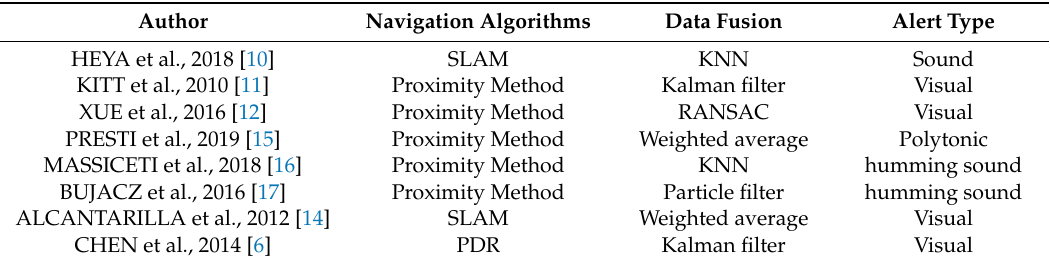
Table 1. Indication of the approaches presented. RANSAC, random sample consensus; KNN, K-nearest neighbors algorithm; PDR, pedestrian dead